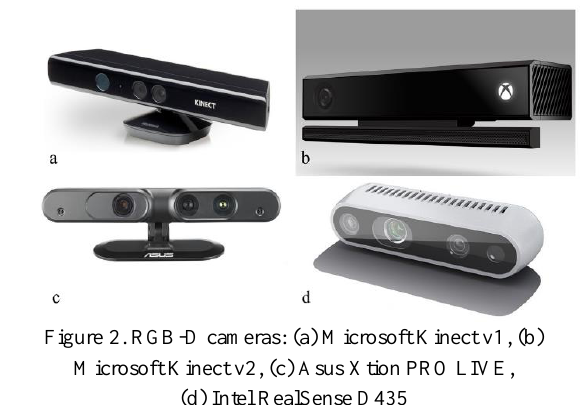
Figure 2. RGB-D cameras: (a) Microsoft Kinect v1, (b) Microsoft Kinect v2, (c) Asus Xtion PRO LIVE, (d) Intel RealSense D435